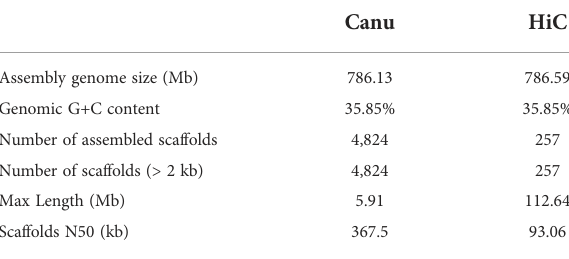
TABLE 1 Assembly statistics of B. vulgaris IMA1nuclear genome.